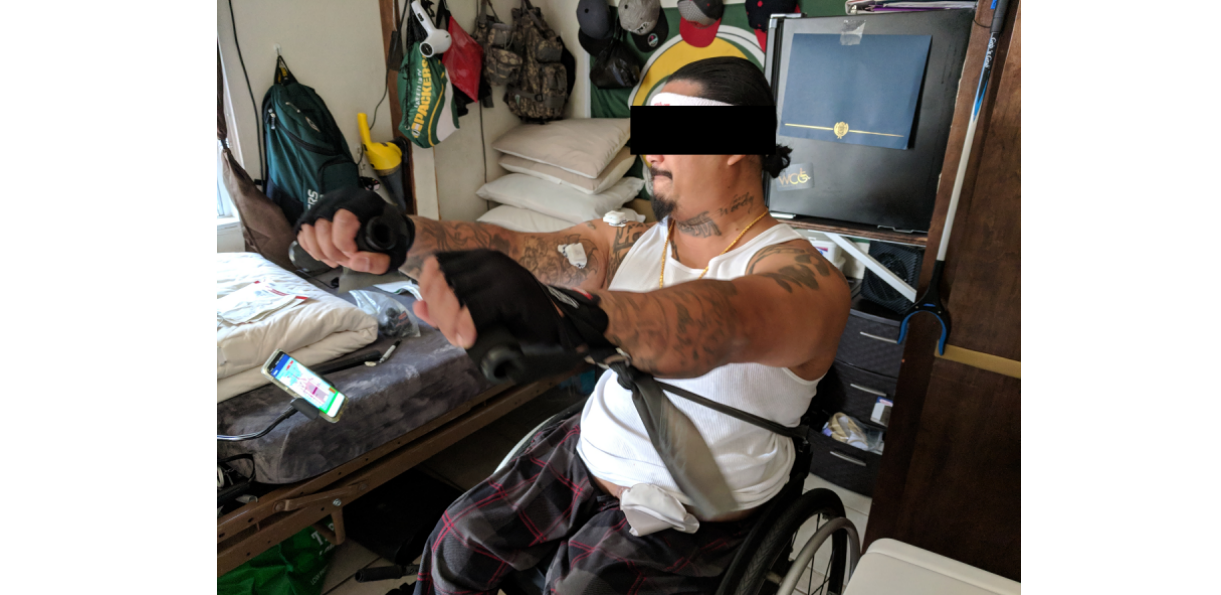
Figure 2. User carrying out chest press exercise to play the high striker exergame.